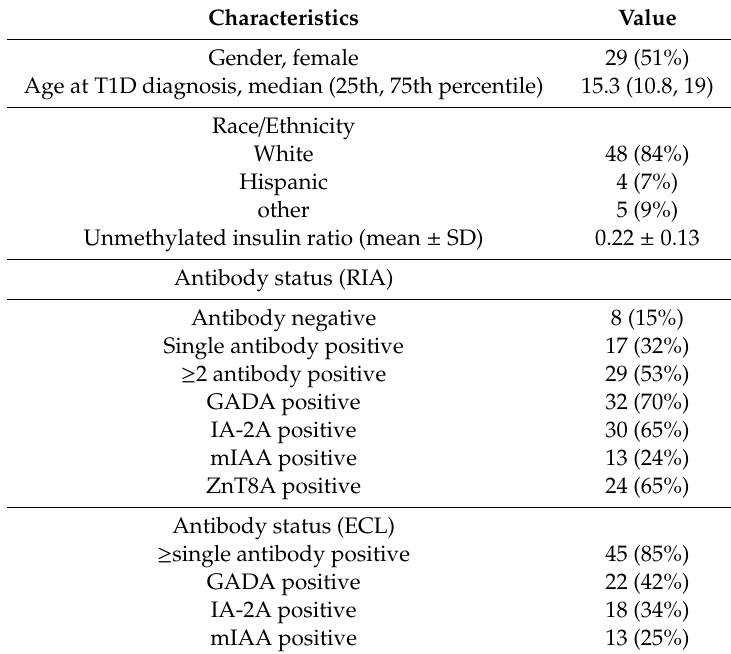
Table 1. Characteristics of TrialNet Participants at Type 1 Diabetes (T1D) Onset ( n = 57). Characteristics Value Gender, female 29 (51%) Age at T1D diagnosis, median (25th, 75th percentile)